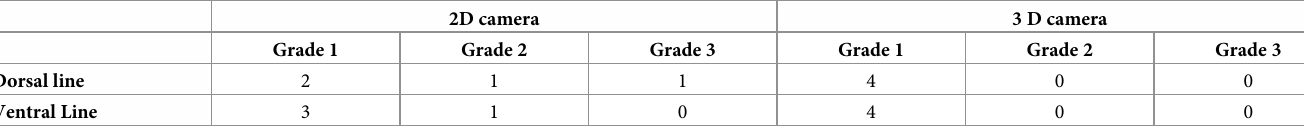
Table 1. Distribution of the spacing grades for the dorsal and the ventral suture lines performed with a 2-D and a 3-D